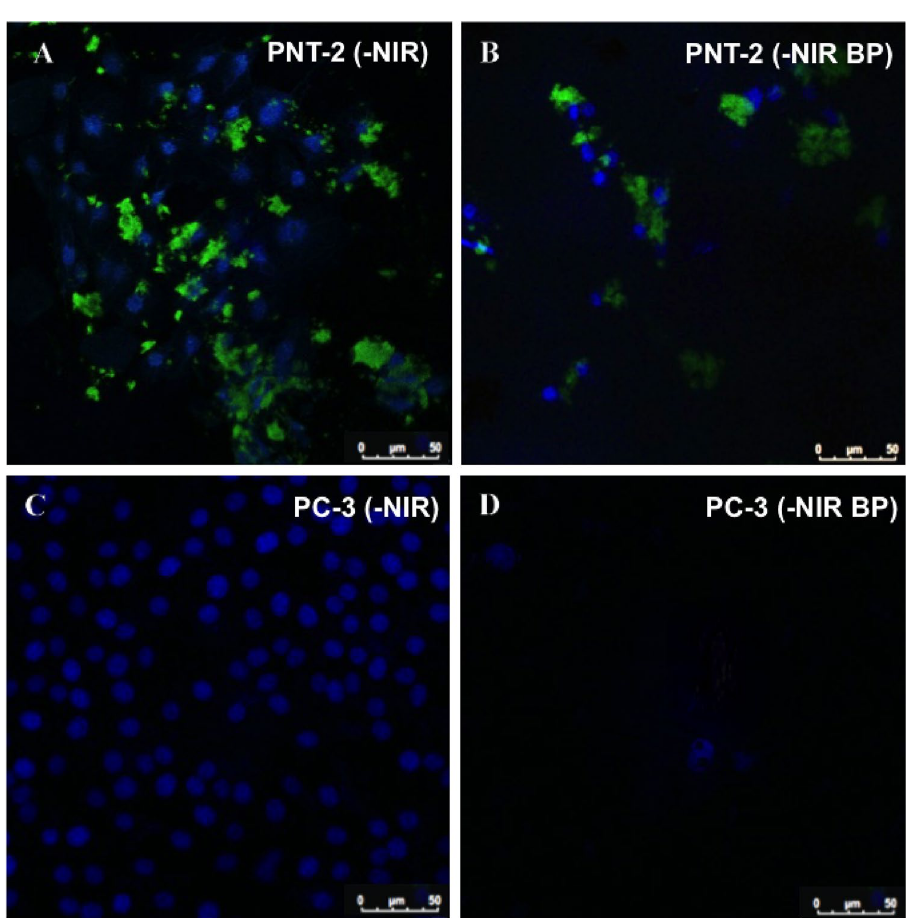
Figure 6. GPX-3 expression in PNT-2 ( A , B ) and PC-3 ( C , D ) cells in presence of 2D BP without infrared (-NIR) irradiation. PNT-2 and PC-3 cell GPX-3 expression in absence (A,C) and in presence 2D BP exposure at concentrations of 5 (B,D) μg/mL after of 24 h of cell culture. The images are representative of three